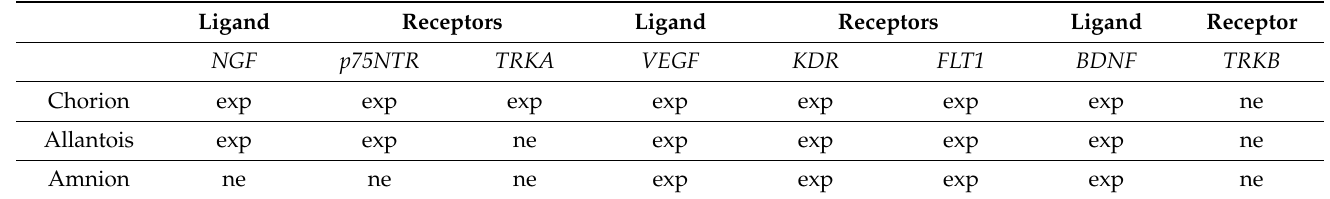
Table 4. Gene expression of NGF, VEGF, BDNF and their receptors in the three portions of placenta: chorion, allantois and amnion. Data are shown as gene expressed (exp) or not expressed (ne). Genes were indicated as expressed (exp) if they were amplified with a Cq ≤ 37. p75NTR = p75 neurotrophin receptor; TRKA = tyrosine kinase receptor A; KDR = kinase insert domain containing receptor; FLT1 = fms-like tyrosine kinase 1; TRKB = tyrosine kinase receptor